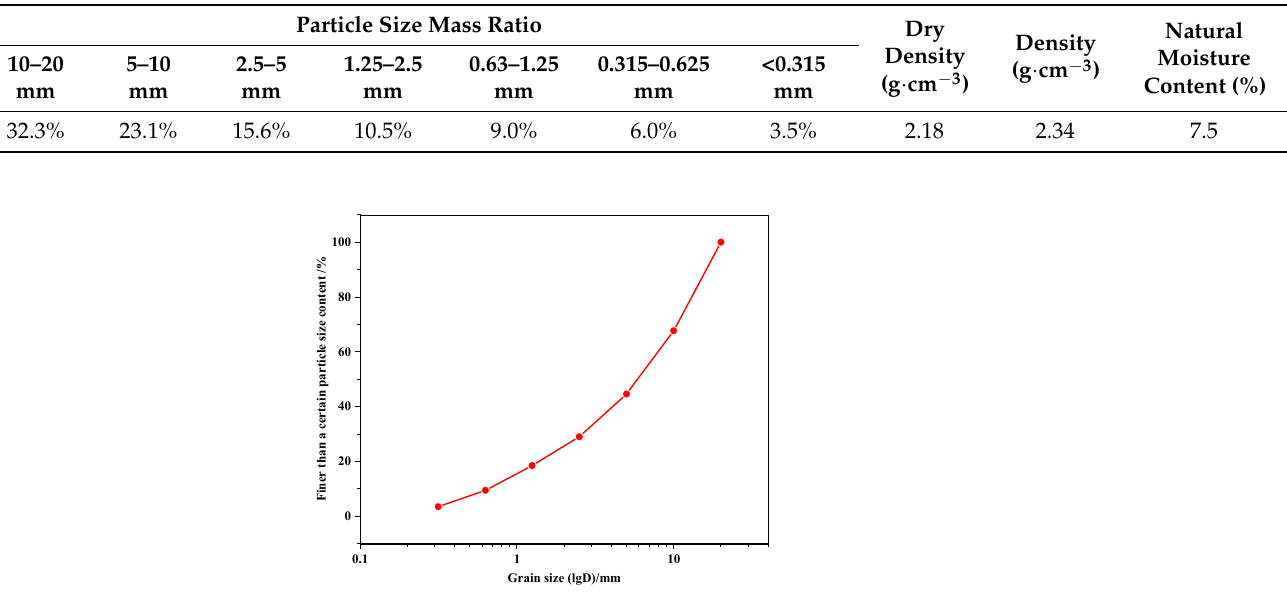
Figure 1. Cumulative curve of particle size gradation of samples.